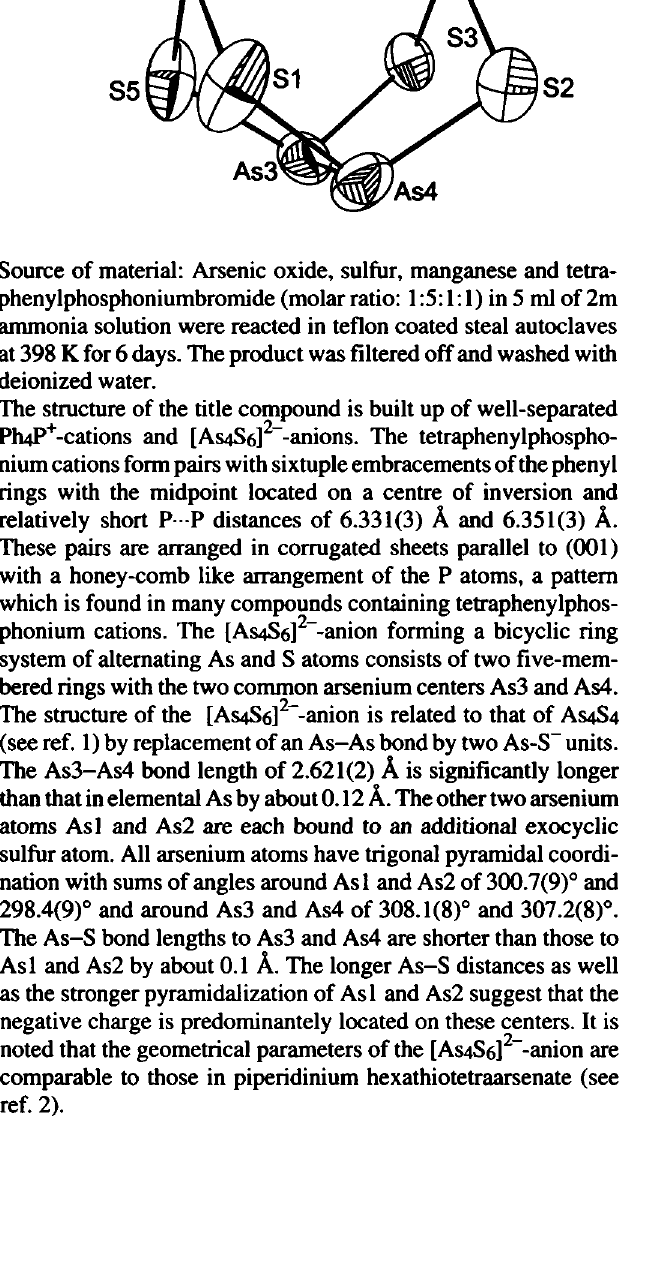
Table 1. Parameters used for the X-ray data collection Crystal: